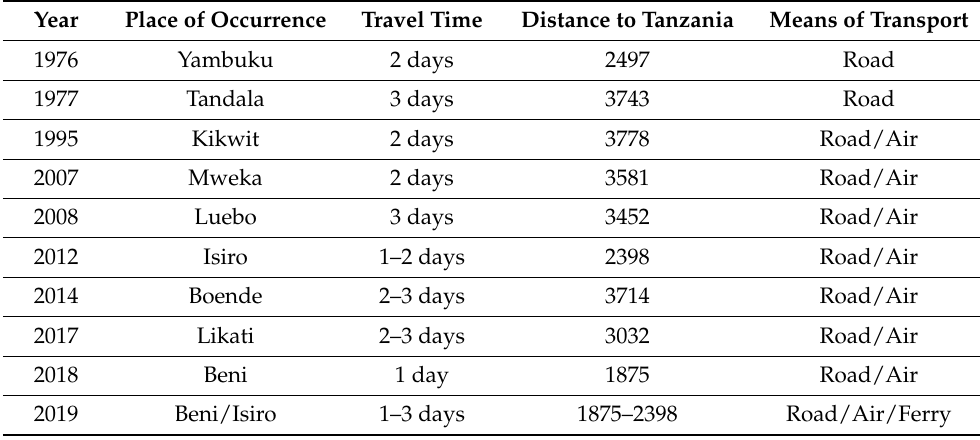
Table 1. Year of the outbreak, place of occurrence, and estimated time and distance to